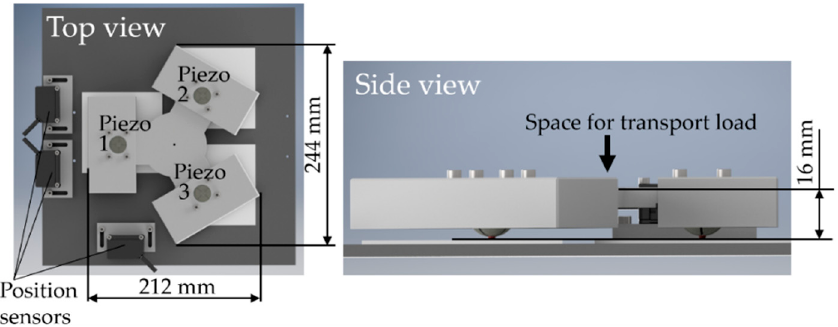
Figure 2. Design (CAD) and outer dimensions of the planar motor drive platform.